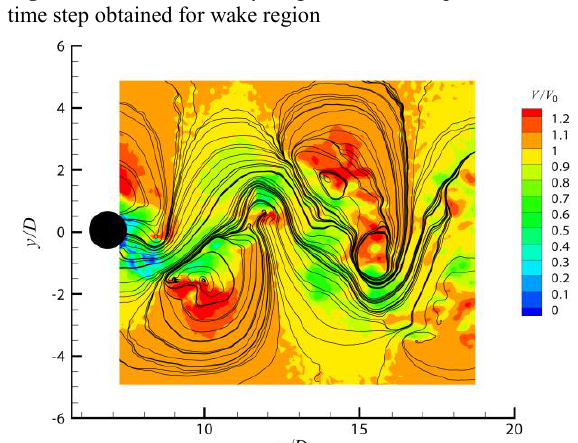
Fig.17 . Normalized velocity magnitude contour plot at third time step obtained for wake region